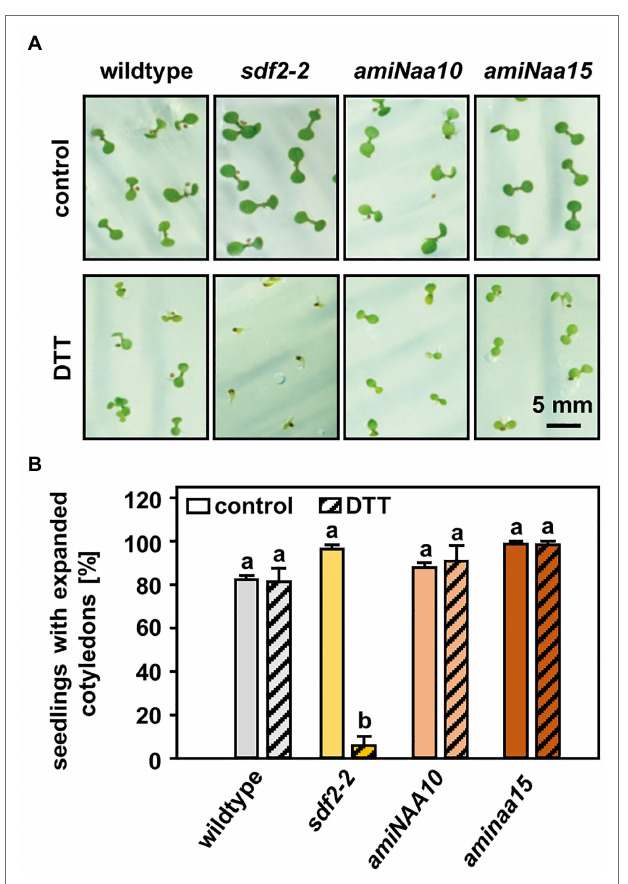
FIGURE 2 | NatA mutants do not display an increased sensitivity to reductive stress. (A) Seeds of NatA mutants, the ER stress-sensitive positive control sdf2-2 ( Arabidopsis stromal-derived factor 2 ), and wildtype plants were surface sterilized, stratified, and germinated on 1×MS medium (control) or 1×MS medium supplemented with 2.5 mM DTT. Seedling was grown under short-day conditions as described in material and methods. Images were taken 10 days after stratification (scale bar = 5 mm). (B) Quantification of seedlings with expanded cotyledons. Data given as means ± SE. Different letters indicate individual groups identified by pairwise multiple comparisons with a Holm-Sidak, One-way ANOVA ( p < 0.05, n = 3, 1n ≥ 20 seedlings).